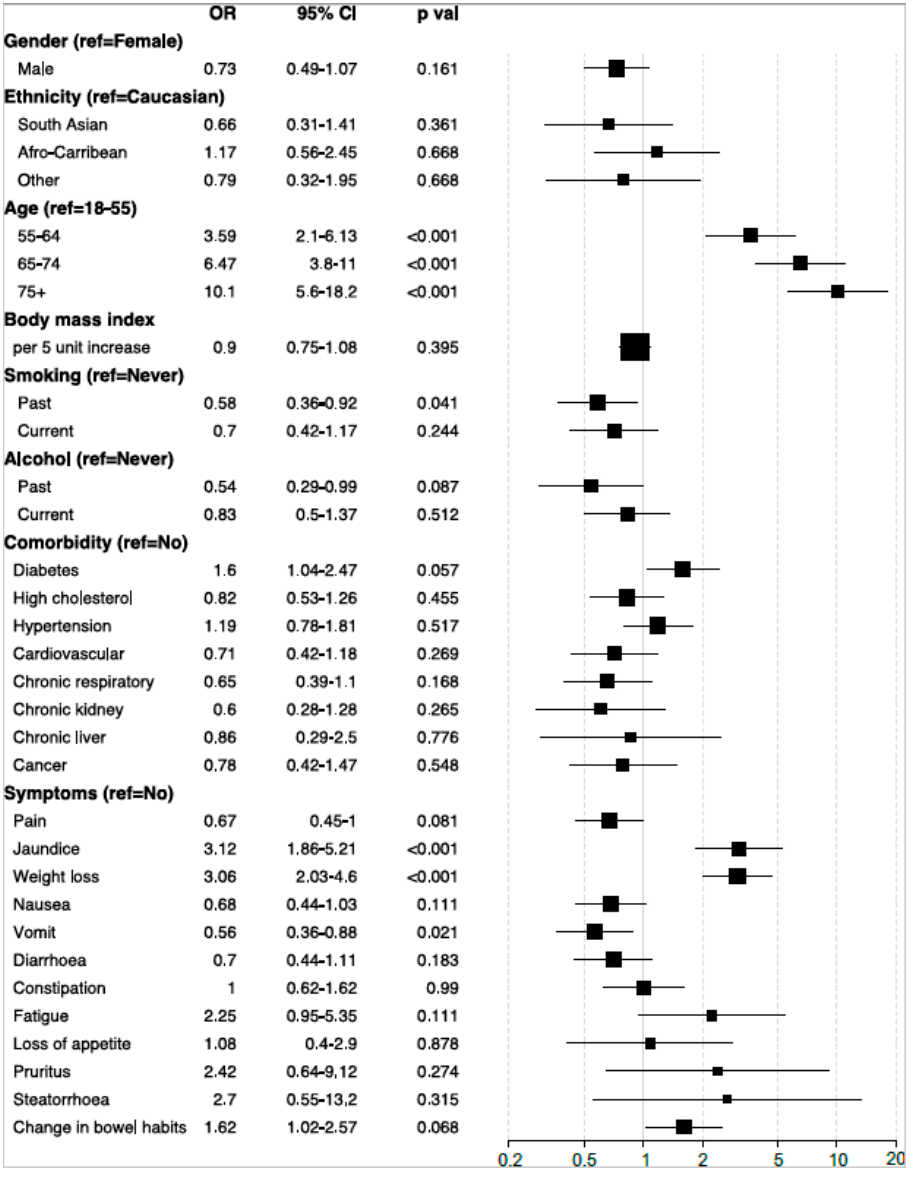
Figure 2. Forest plot showing the association between study variables (demographic, lifestyle, comorbidity and symptom) and odds of PDAC in comparison to the non-malignant pancreatic disease group. The odds ratio (OR) and 95% confidence interval (CI) are derived from the logistic regression model controlled for gender, ethnicity and age group. The reported p values are corrected for multiple testing via the Benjamini–Hochberg method.